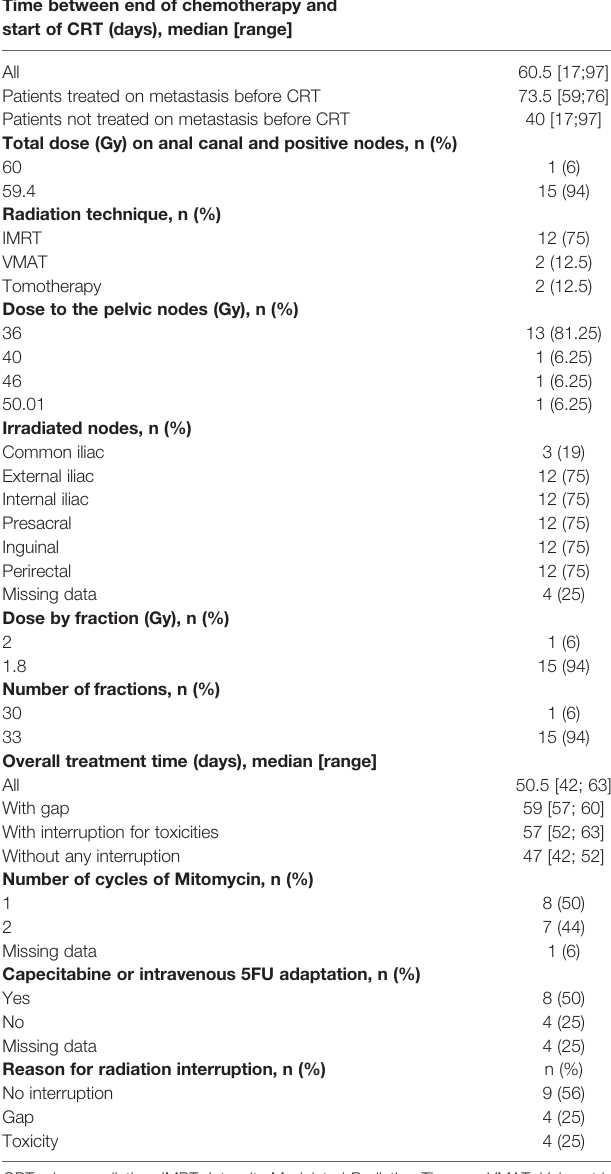
TABLE 3 | Chemoradiation characteristics. Time between end of chemotherapy and start of CRT (days), median